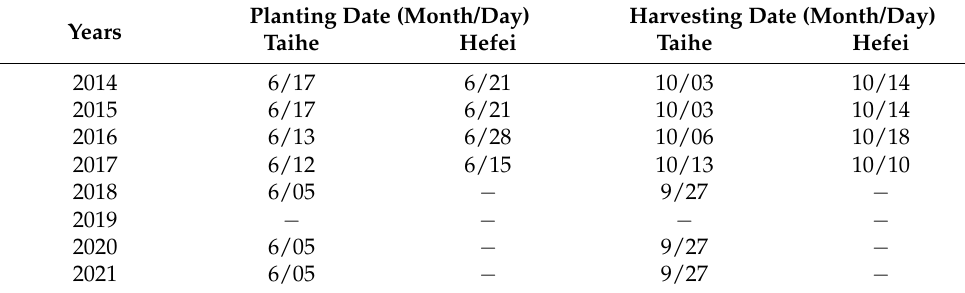
Table 3. The planting dates and harvesting dates in Taihe and